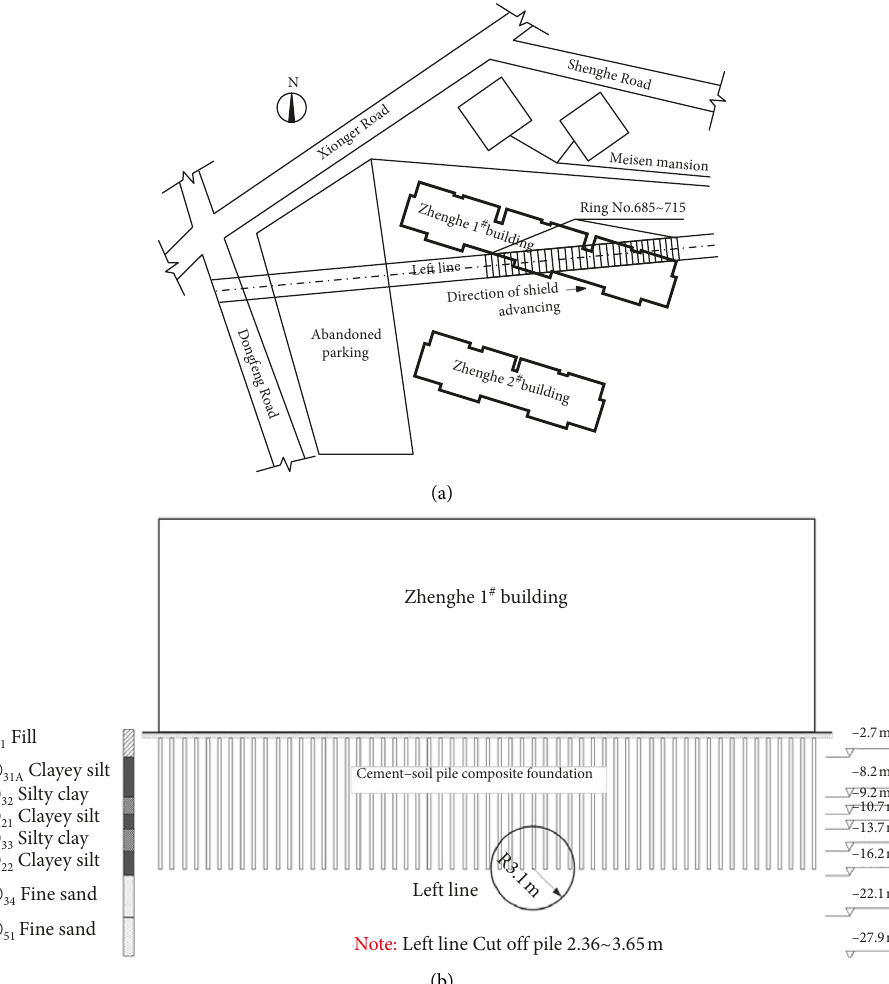
Figure 1: Relative position of the Zhenghe 1#: (a) schematic plane location of the tunnel and Zhenghe 1# building; (b) schematic elevation of the tunnel and Zhenghe 1#